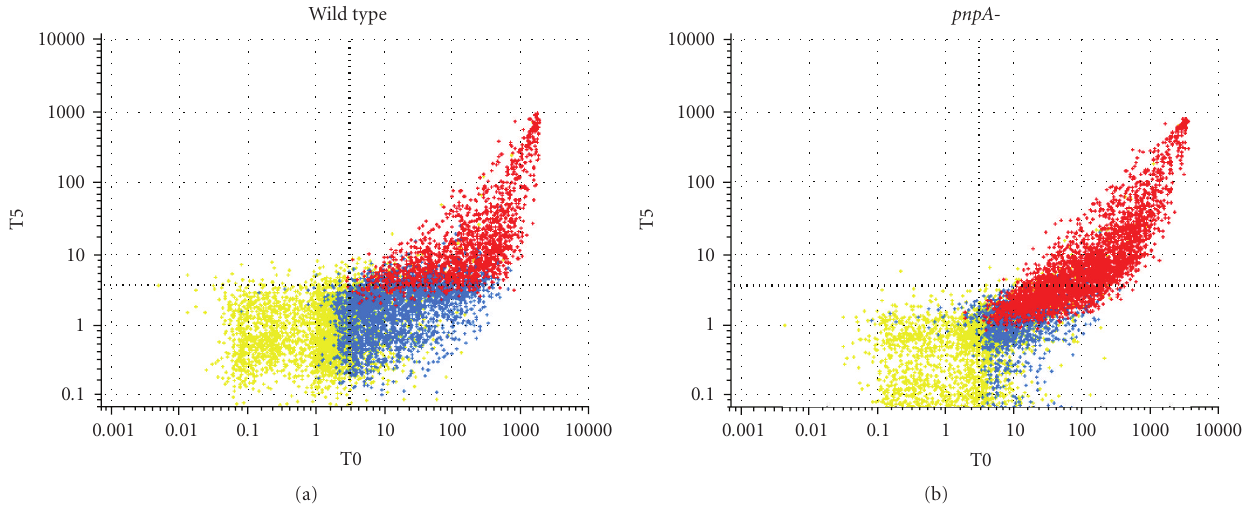
Figure 4: Degradation profiles of S. aureus wild type and pnpA-mutant cells. RNA signal intensity values for each GeneChip transcript are plotted at 0 minute (T0; X -axis) and 5 minutes (T5; Y -axis) posttranscriptional arrest. Red represents transcripts considered “present” in both T0 and T5 samples (A ff ymetrix algorithms). Yellow represents transcripts that are “absent” in both samples. Blue represents transcripts that are present in one sample but absent in the second. Grey dashed lines indicate calculated lower limit of sensitivity for each sample. Results show that following 5 minutes of transcriptional arrest, 51.1% (1287 transcripts) of mRNA species are completely degraded within wild type S. aureus cells. Conversely, 17.6% (444 transcripts) of mRNA species were undetectable within isogenic pnpA -mutant cells at 5 minutes posttranscriptional arrest, suggesting that PNPase plays a role in global S. aureus mRNA